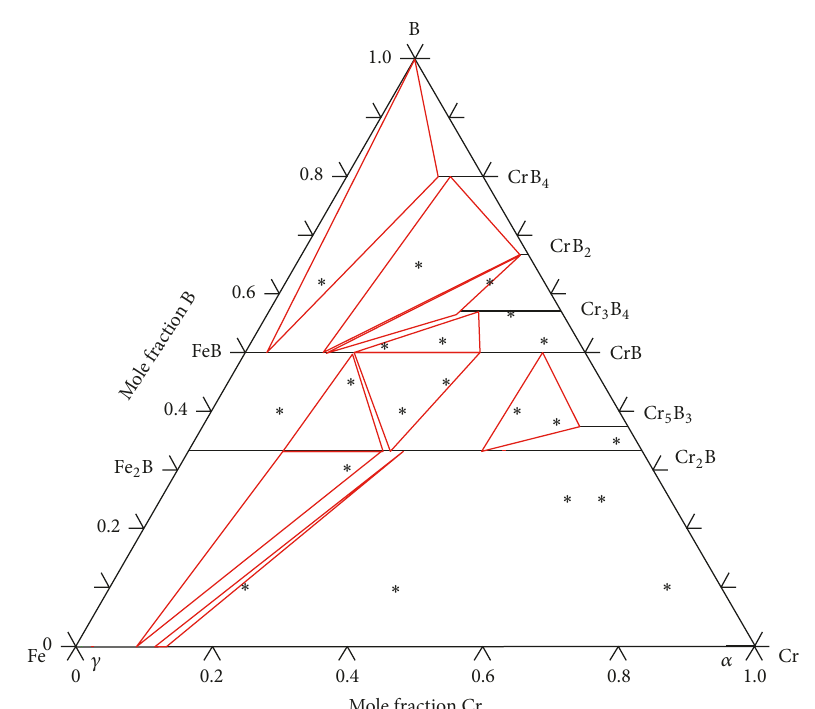
Figure 4: The experimentally determined isothermal section of the B-Cr-Fe phase diagram at 1353 K. Compositions of model alloys are marked by ∗